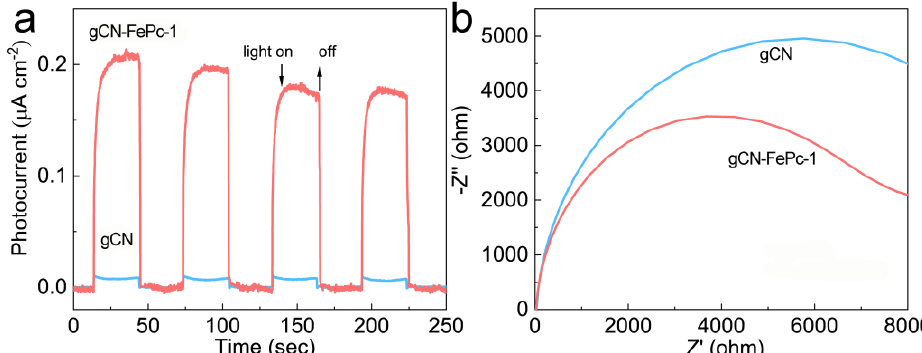
Figure 8. Transient photocurrent responses ( a ) and EIS plots ( b ) of samples.